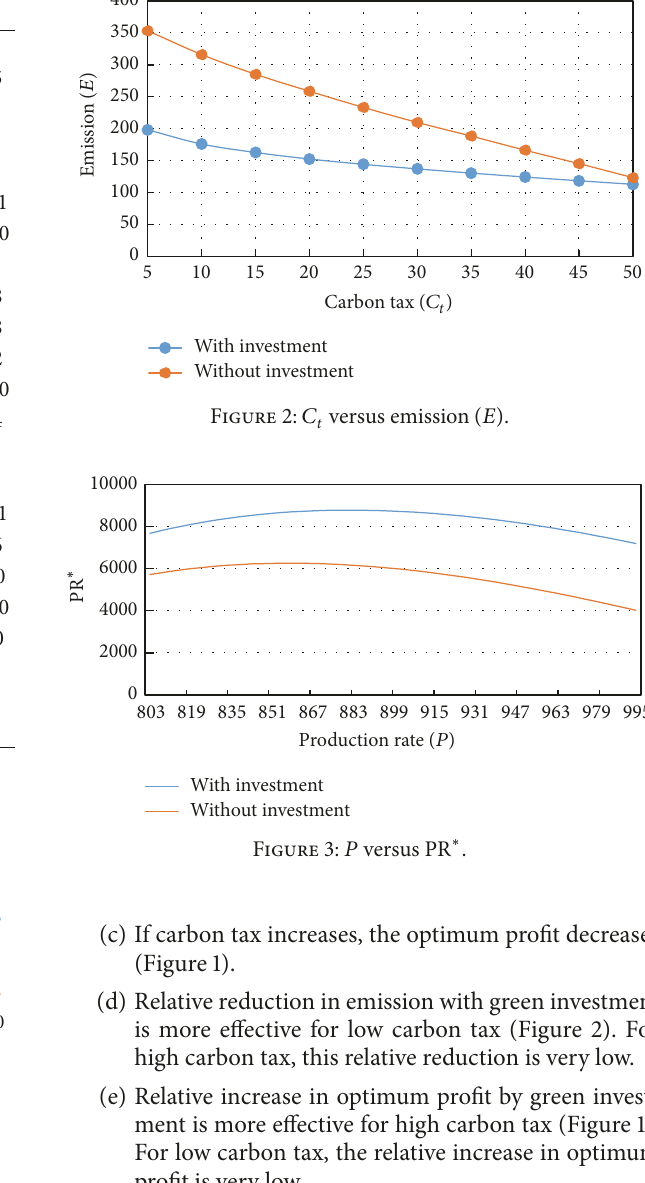
Figure 3: 𝑃 versus PR ∗